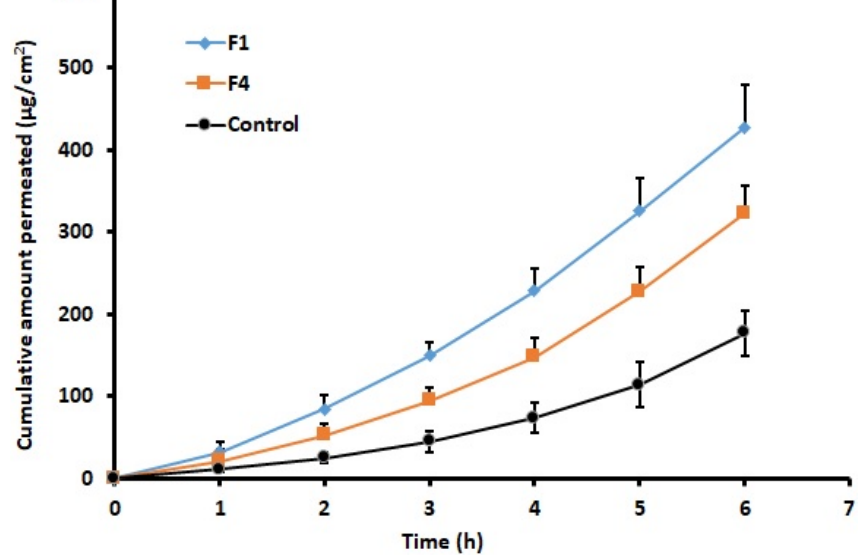
Figure 6. Ex vivo permeation of rizatriptan across rabbit buccal mucosa from buccal films (F1 and F4) and control. Data represented are mean ± SD ( n =